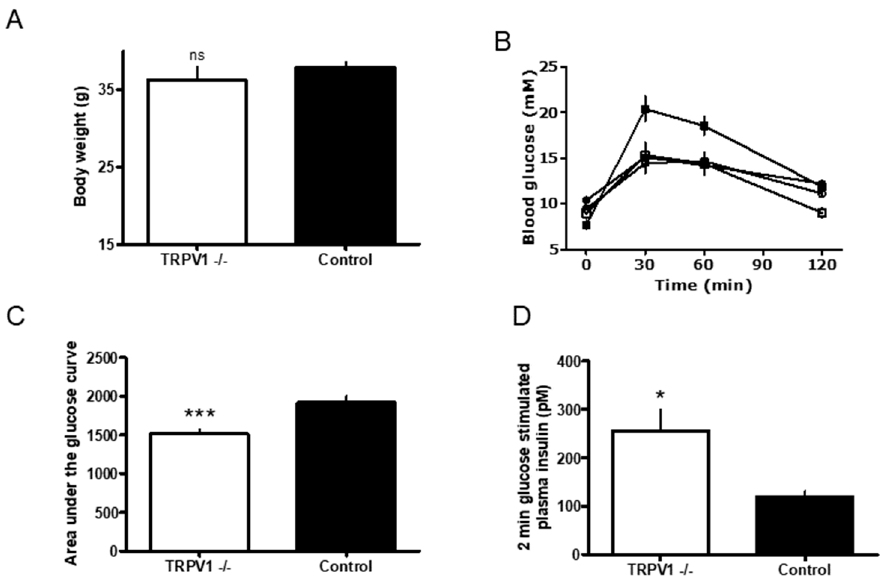
Figure 1. ( A ) The terminal bodyweight of Trpv1 knock out (KO) (open bar) and wild-type (closed bar) mice on high-fat diet (HFD, open bar). Comparison between the two HFD groups were performed using a two tailed t -test, p < 0.05 considered statistically significant. Data are represented as n = 10, mean ± Standard Error of the Mean, SEM. ( B ) Blood glucose levels measured in the oral glucose tolerance test (OGTT) in Trpv1 KO ( n = 10) and wild-type ( n = 10) mice. Trpv1 KO mice were kept on low fat diet (LFD) until the age of 8 weeks (open circles); and then for 16 weeks on high fat diet, HFD (open squares). Wild-type mice on LFD and HFD are represented by open and closed squares, respectively. Glucose was given orally by gavage at time 0 and plasma glucose was assessed prior to this and 30, 60 and 120 min after oral glucose. Blood samples were taken from the tail tips of conscious mice. ( C ) The area under the curve (AUC) analysis of blood glucose levels measured in Trpv1 KO (open bar) and wild-type (closed bar) mice on HFD during OGTT. Data are from ( B ). *** p = 0.0007. ( D ) The glucose stimulated insulin secretion in Trpv1 KO mice (open bar) and control mice on HFD (closed bar). Mice were given a single intraperitoneal glucose injection and plasma insulin was measured 2 min after the administration of glucose. Samples were obtained, as described above. * p = 0.0062.